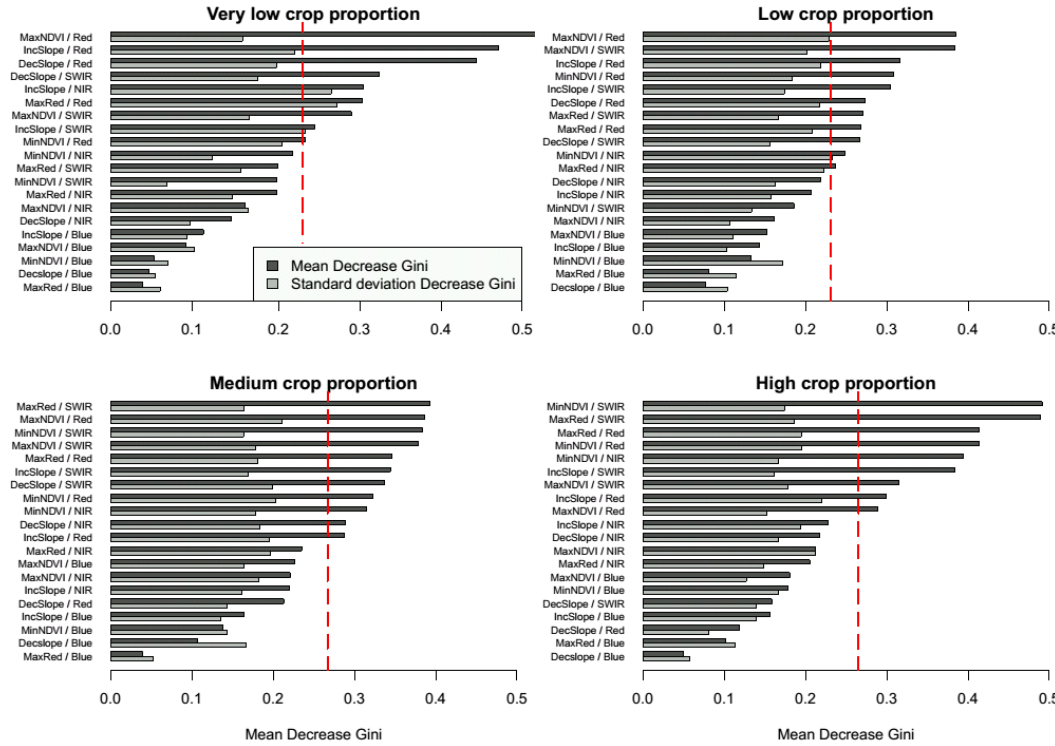
Figure 9. Respective contribution of each spectral-temporal feature for crop discrimination for the different cropland density classes. The dotted red line corresponds to the decision rule for selecting the best